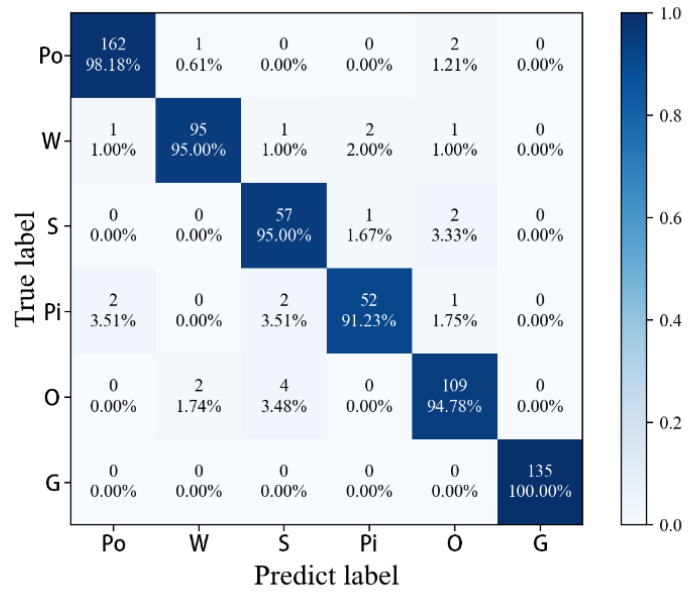
Figure 10. MALSTM-FCN confusion matrix.